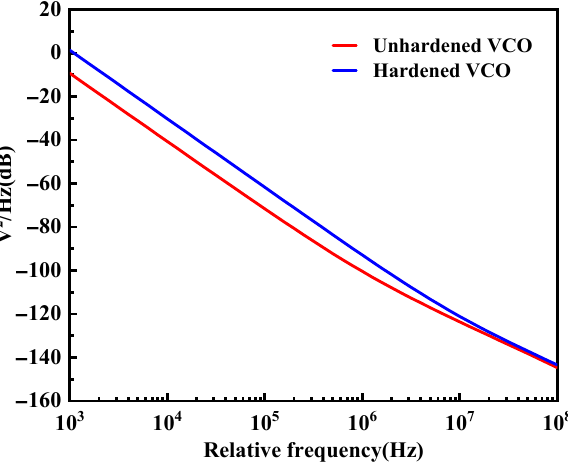
Figure 10. Simulation results of the phase noise of the VCO before and after hardening.